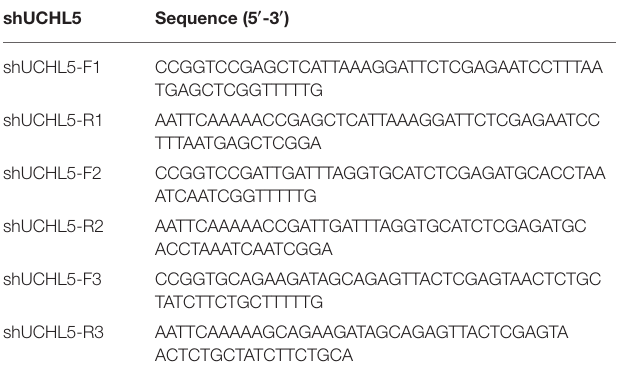
TABLE 1 | Sequences of shUCHL5.